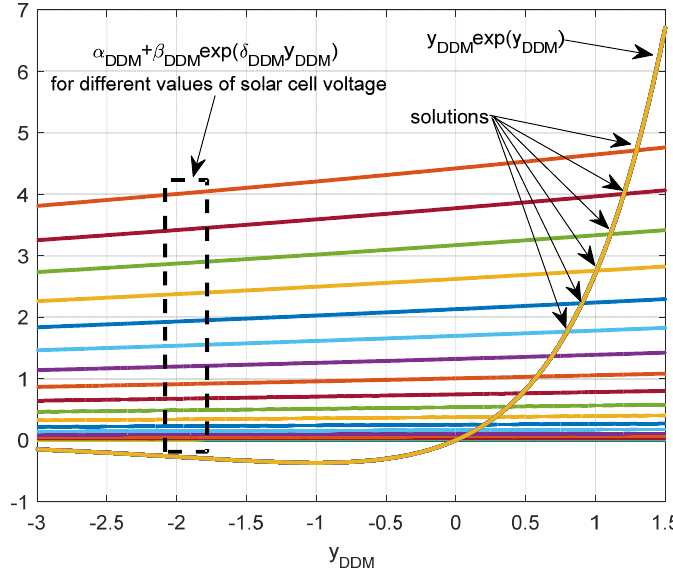
Figure 11. Visualization of α DDM + β DDM e δ DDM y DDM and y DDM e y DDM .